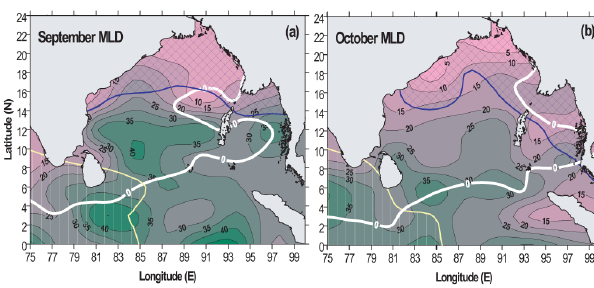
Figure 7. Monthly mean climatology of mixed layer depth (m) in the Bay of Bengal during fall intermonsoon in (a) September and (b) October. The blue crosshatch represents the region where salin- ity is less than 32psu, while vertical lines within the thin yellow solid line represent the region where the salinity is greater than 34.5psu. The thick broad white line indicates the zero wind stress curl and the region south of it (equatorward) have positive wind stress curl.